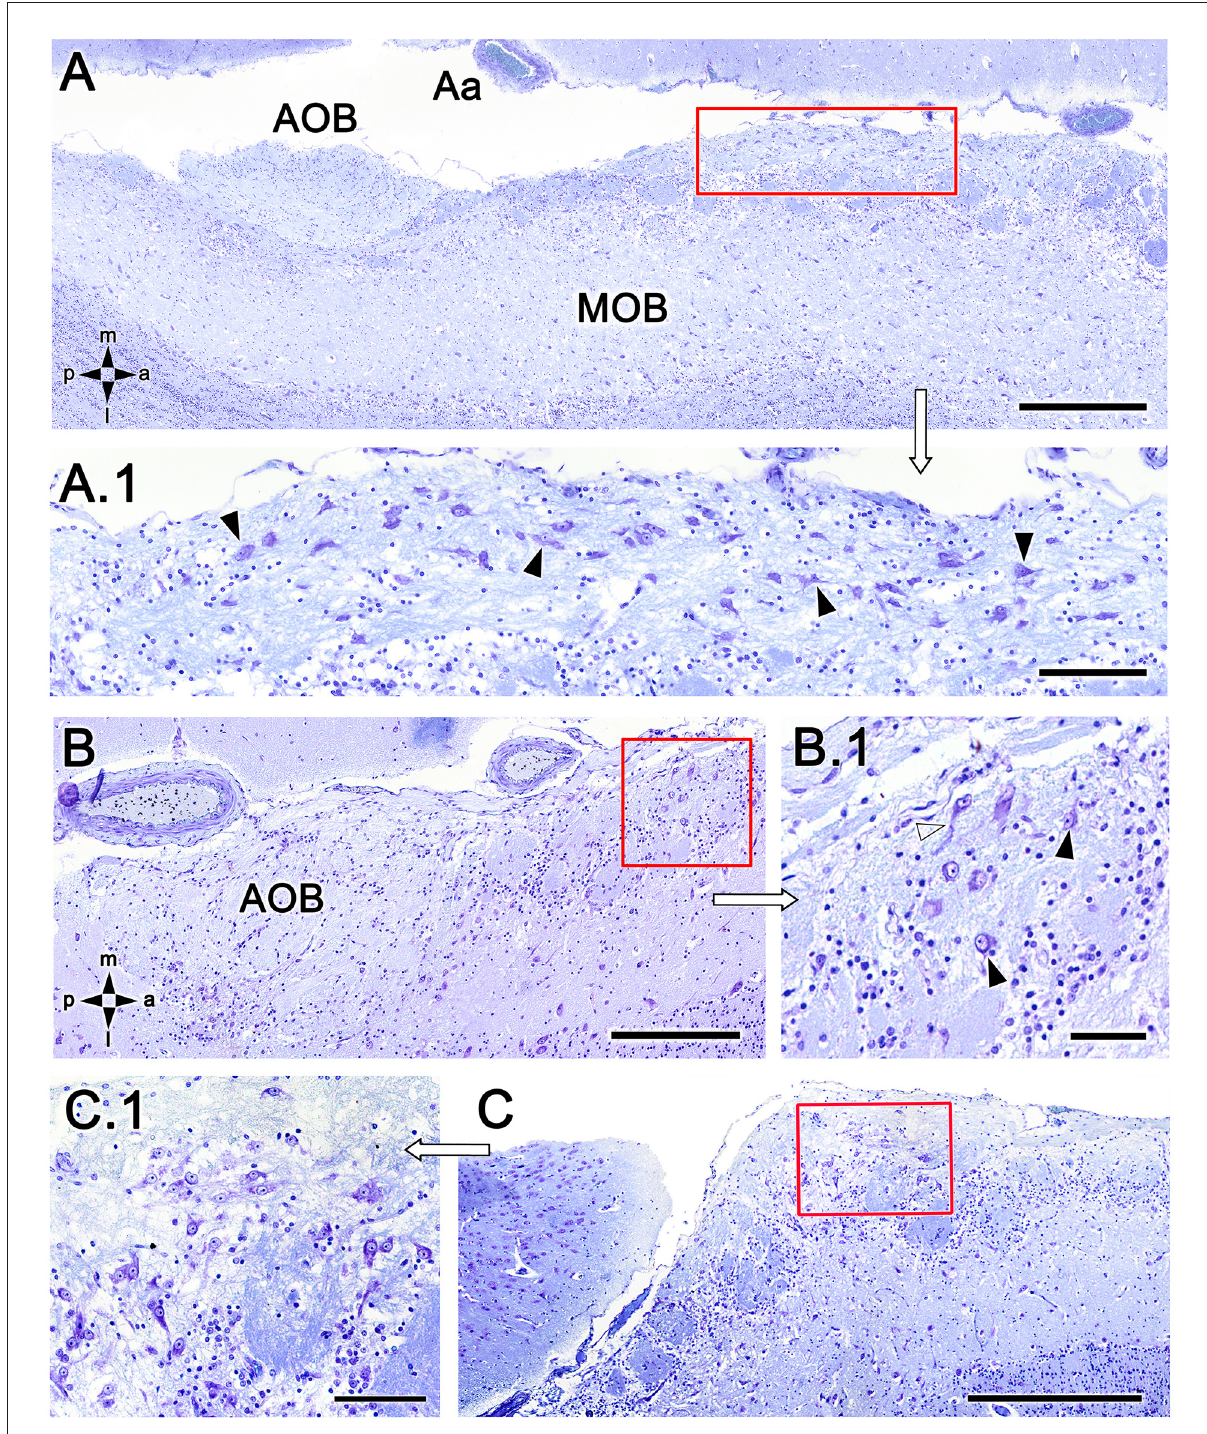
FIGURE5 Nissl-stained sections of the fox olfactory limbus (OL). (A) A ventral section shows the topography of the nervous formation, located on the bulbar surface, superficial to the glomeruli. (A.1) A higher magnification of the red box in (A) shows numerous neuronal somata (arrowheads). (B) Horizontal section at the level of the AOB. Anterior to the AOB, a superficial neuronal cluster surrounded by atypical glomeruli can be observed (red box, magnified in B.1 ). (B.1) The neuronal somata have oval shapes (arrowheads), and the origin of thick processes is visible (open arrowhead). (C) In this specimen, the neuronal cluster is located in a more anterior position, very close to the pial surface. (C.1) At a higher magnification, the neurons show similar morphology to that of the specimen shown in (B) . Aa, artery; AOB, accessory olfactory bulb; MOB, main olfactory bulb. Orientation: m, medial; l, lateral; p, posterior; a, anterior. Scale bars: (A,C) : 500 µ m. (B) : 250 µ m. (A.1,C.1) : 100 µ m. (B.1) : 50 µ